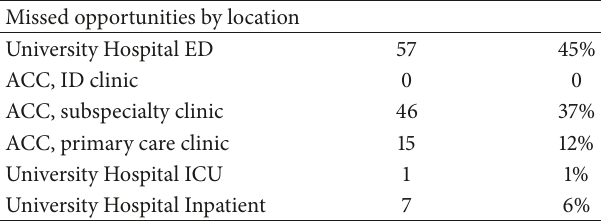
Table 3: Location of missed testing opportunities by location at University Hospital HIV Clinic, Newark, New Jersey, 2013-2014. Missed opportunities by